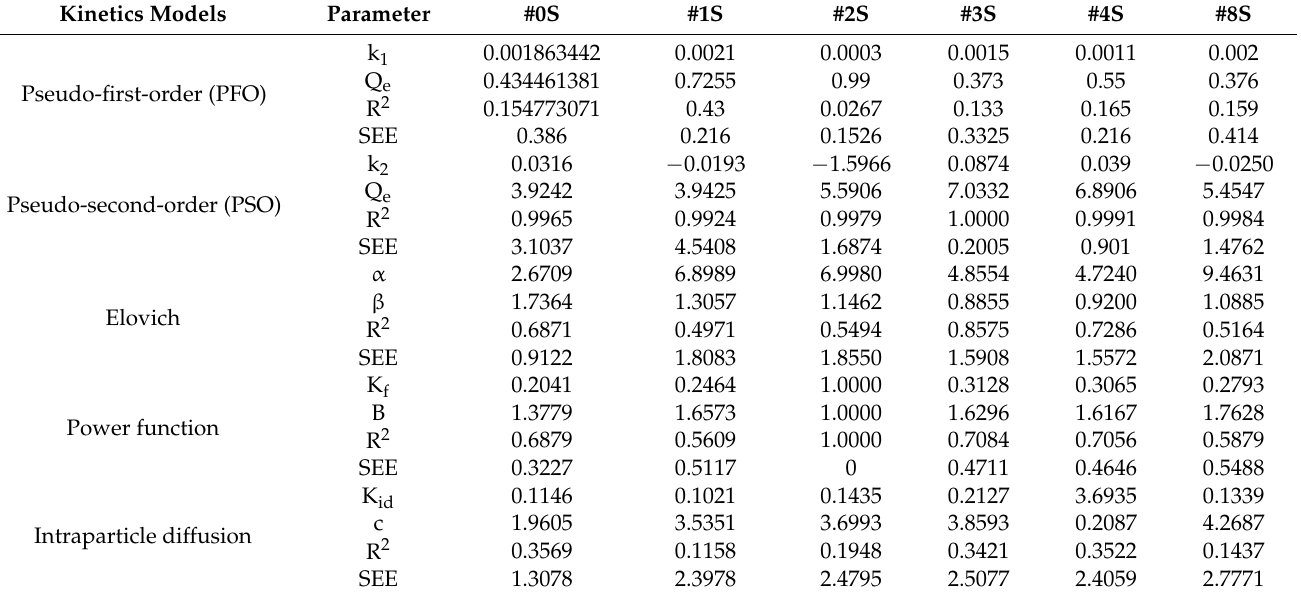
Table 4. The quantification of kinetics model parameters such as PFO, PSO, Elovich, Power function, and Intraparticle diffusion.